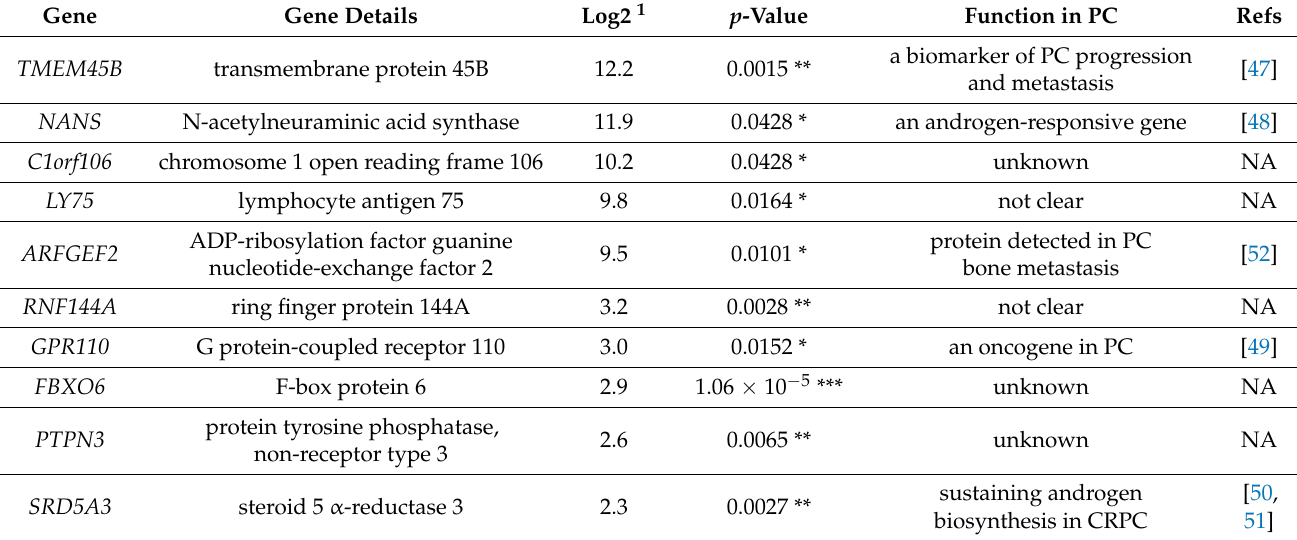
Figure 2. Enrichment of CREIGHTON_ENDOCRINE_THERAPY_RESISTANCE_3 gene set in LNCaP CNTN1 cells. ( A ) Gene set enrichment analysis (GSEA) analysis reveals the enrichment of CREIGHTON_ENDOCRINE_ THER- APY_RESISTANCE_3 gene set in the differentially expressed genes (DEGs) relative to CNTN1 overexpression (LNCaP CNTN1 vs. LNCaP EV). The leading-edge genes ( n = 10) in this enrichment are indicated (see Table 1 for individual leading-edge genes). ( B ) Confirmation of the upregulations of 7 of 10 leading-edge genes in LNCaP CNTN1 cells. ( C ) Table 1. The leading-edge (LE) genes and their function in prostate cancer (PC) and tumorigenesis.